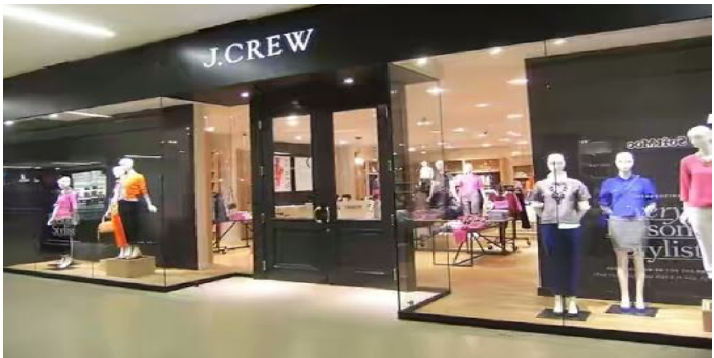
Figure 2. Semi-closed display window style.